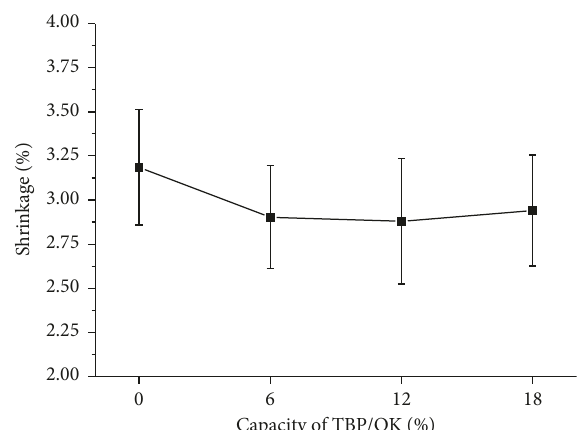
Figure 8: Shrinkage of the solidified SPT samples with different TBP/OK contents.